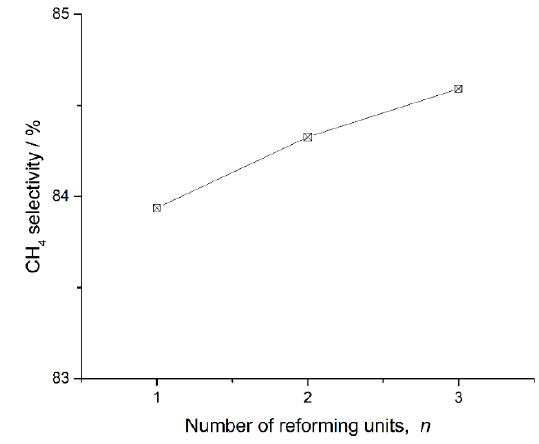
Figure 10. CH 4 selectivity for chemical reformers with different numbers of reforming units.